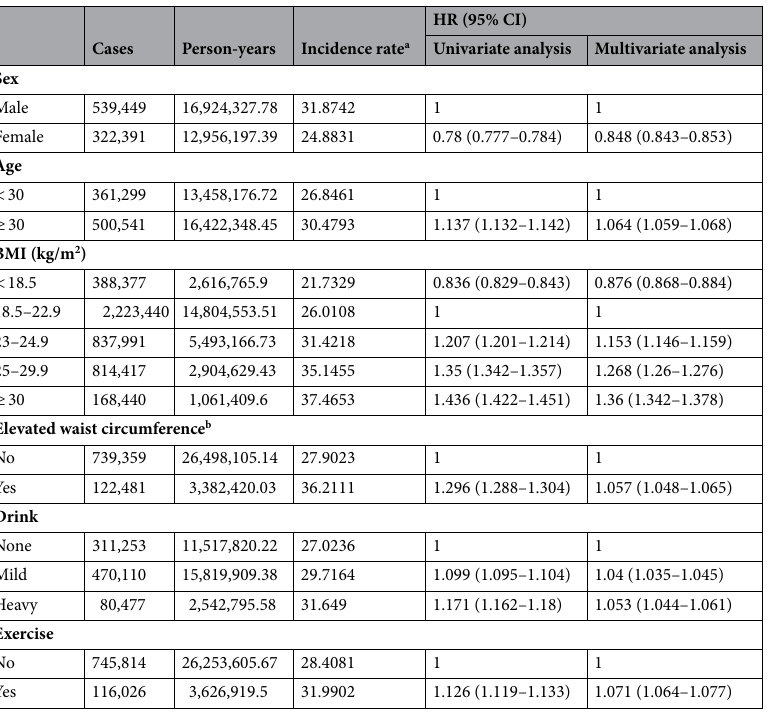
Table 2. Association between suspected risk factors and the incidence of dermatophytosis. Values are expressed as hazard ratios (95% confidence intervals) using univariate and multivariate Cox proportional hazards regression analyses. BMI body mass index, CI confidence interval, HR hazard ratio. a Incidence rates are expressed in units of per 1000 person-years. b Elevated waist circumference is defined as a waist circumference of more than 90 cm in men or more than 85 cm in women.